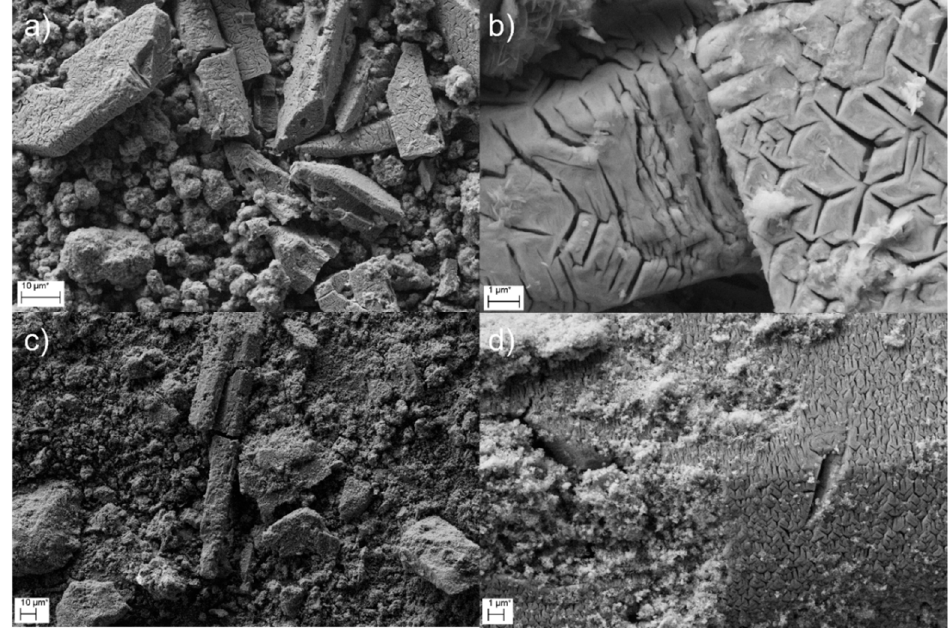
Figure 8 . SEM images of the precipitates (Mg:P:N 1.3:1:2 for MgO and 1.3:2:2 for dolomite): ( a , b ) MgO; and ( c , d ) dolomite 750 °C. Scale bars: ( a , c ) 10 µm; and ( b , d ) 1 µm.